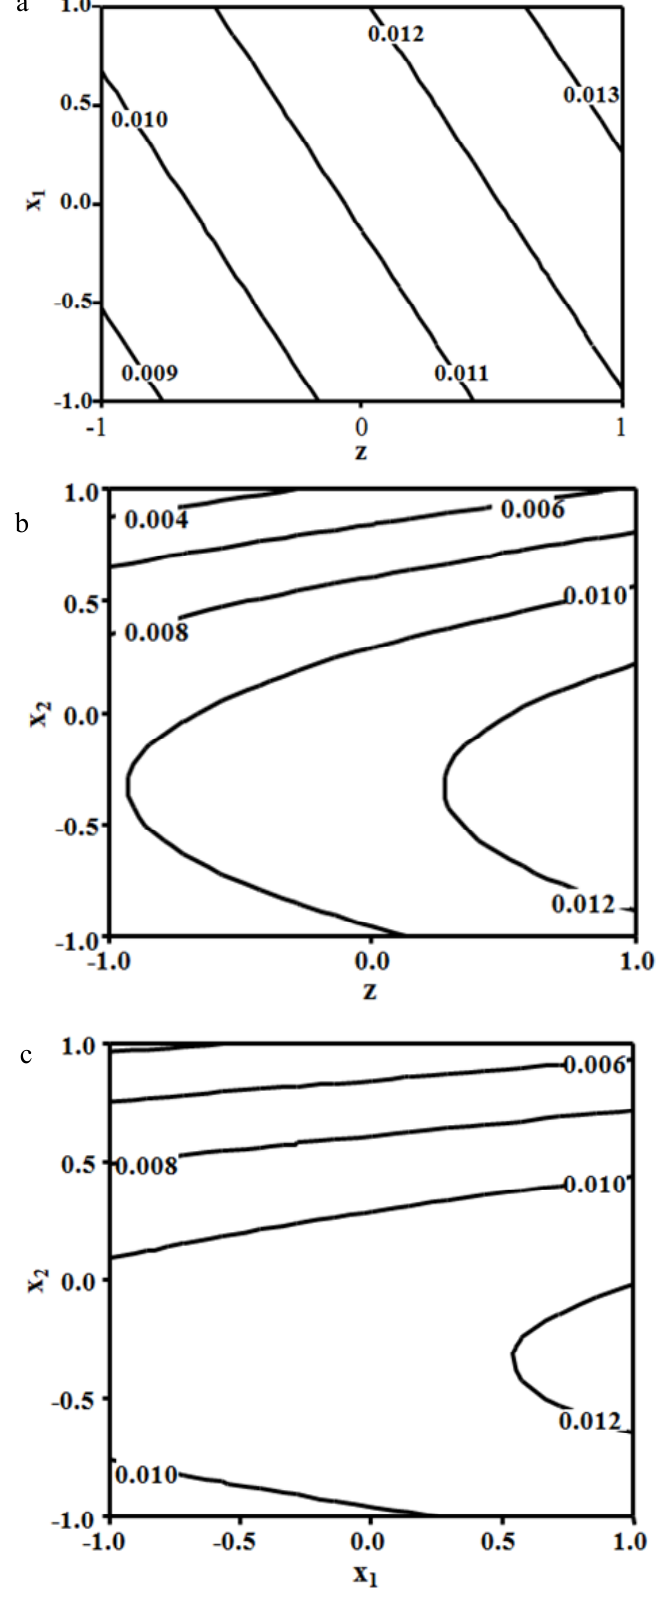
Figure 5. Contour plots of the apparent degradation rate constant for ( a ) temperature versus reactant; ( b ) particle size versus reactant; and ( c ) particle size versus